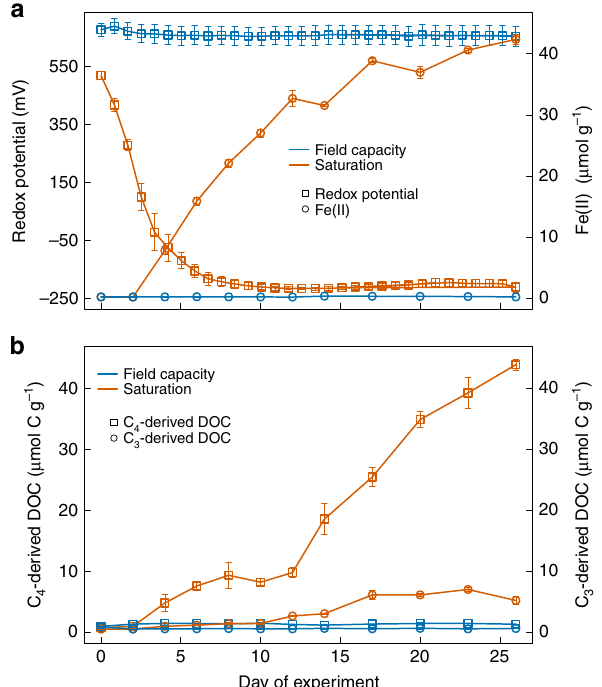
Fig. 4 Temporal chemical variations in footslope soils incubated under fi eld capacity and saturation. a Redox potential (Eh) and ferrous iron (Fe(II)); b dissolved organic carbon (DOC) from C 4 and C 3 sources. The error bars indicate s.e.m. ( n = 4, except for Eh where n =